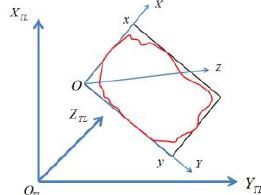
Figure 2. Projection plane coordinate diagram